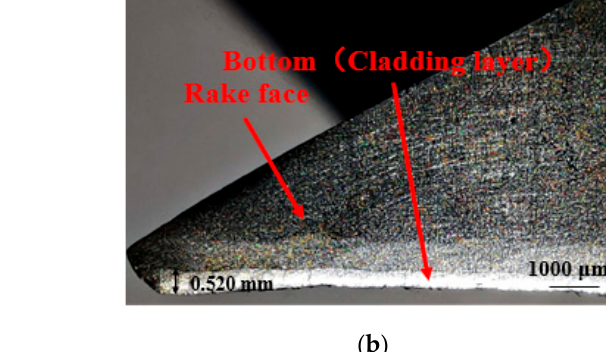
Figure 1. ( a ) Macro-morphology of the silage knife after cladding; ( b ) cross-section morphology of the knife’s edge after cladding. Table 1. Chemical composition of the knife and nickel alloy.